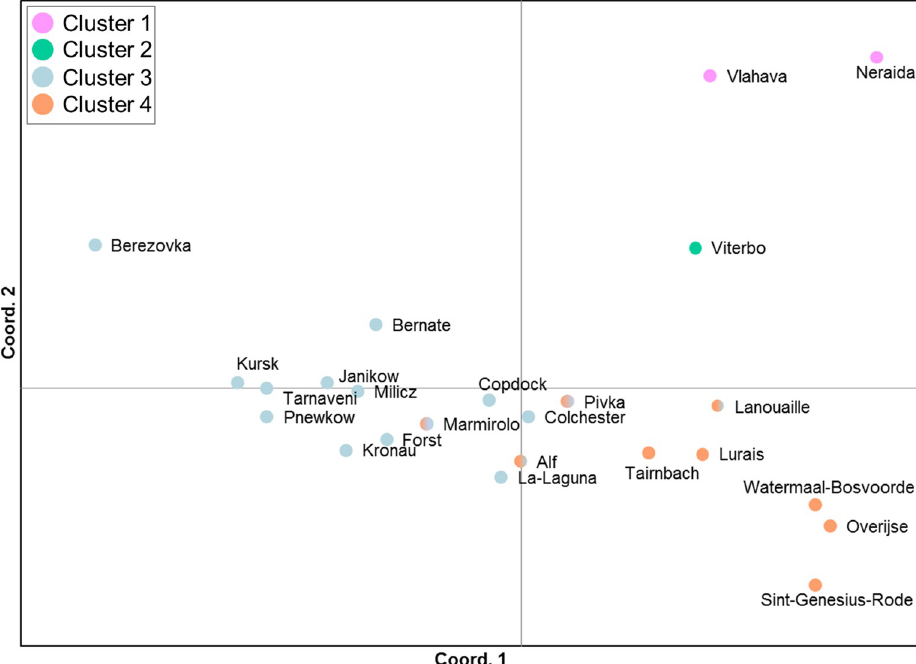
Fig 8. Principal Coordinates Analysis (PCoA) of population pairwise F ST values for microsatellite genotypes of Lucanus cervus . The dots are coloured according to the clusters defined by BAPS (see Fig 5B and S2 Fig).